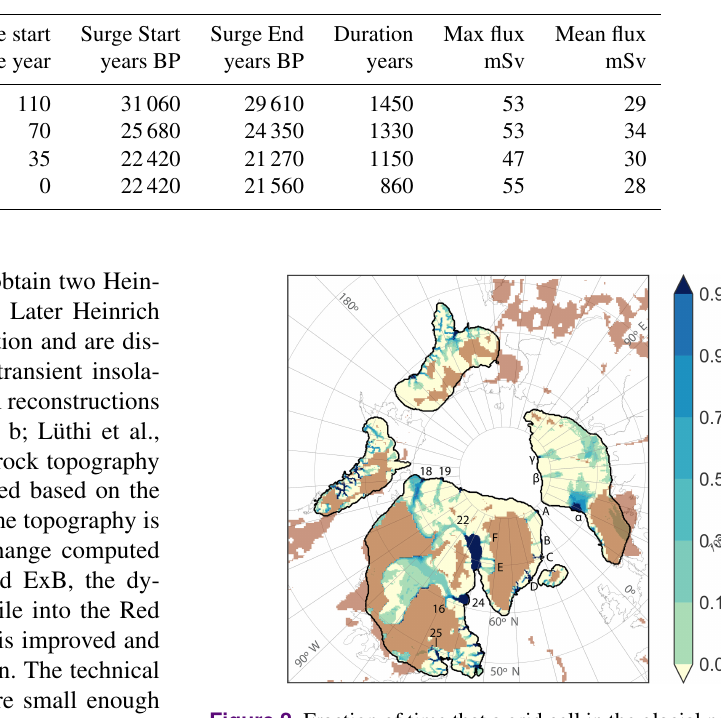
Figure 2. Fraction of time that a grid cell in the glacial part of ExA (41–15.6ka) is sliding or has floating ice with a basal velocity ex- ceeding 1myr − 1 . Only the time when the grid cell is ice covered is taken into consideration; therefore, ice shelves are considered to be constantly sliding. Only areas with a time-mean ice thickness in excess of 10m are displayed. Brown marks areas where the ice is not permitted to slide due to the lack of sediments in the re- construction of Laske and Masters (1997). Numbers match the ice stream numbering in Stokes and Tarasov (2010) and are as follows: Lancaster Sound, (24) Hudson Strait, (25) Laurentian. Letters refer